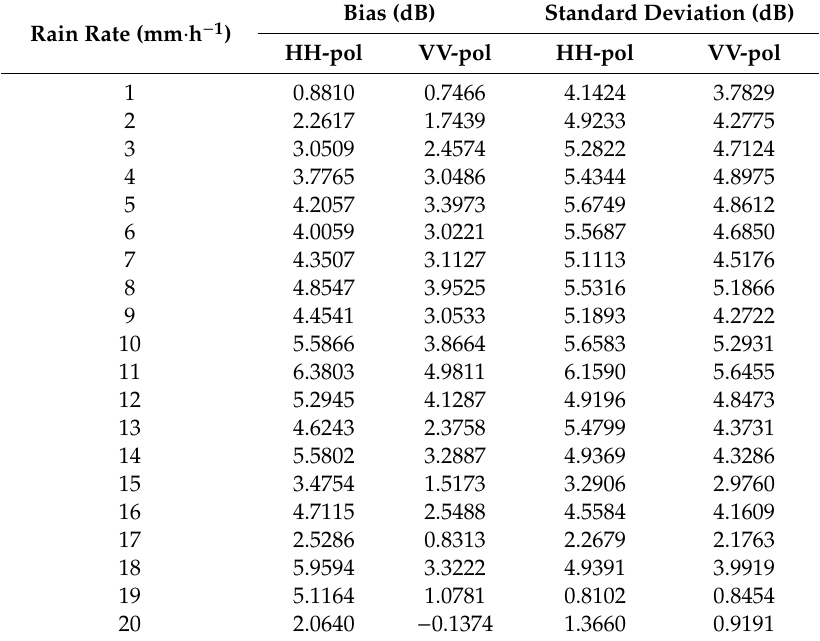
Table 3. HY-2A measure σ 0 and ECMWF model σ 0 statistical